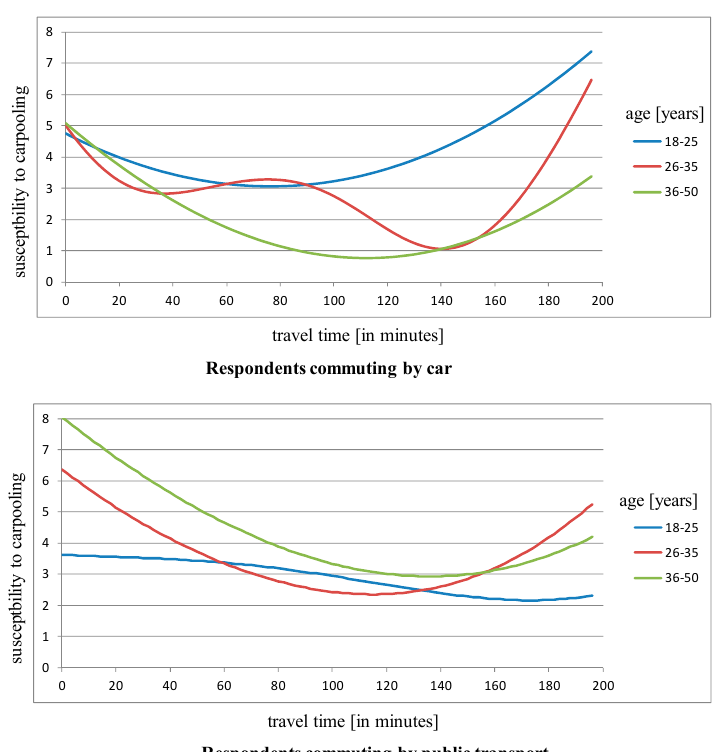
Figure 5. Inclination towards carpooling by means of transport ( upper: car, lower: public transport), travel time, and age.